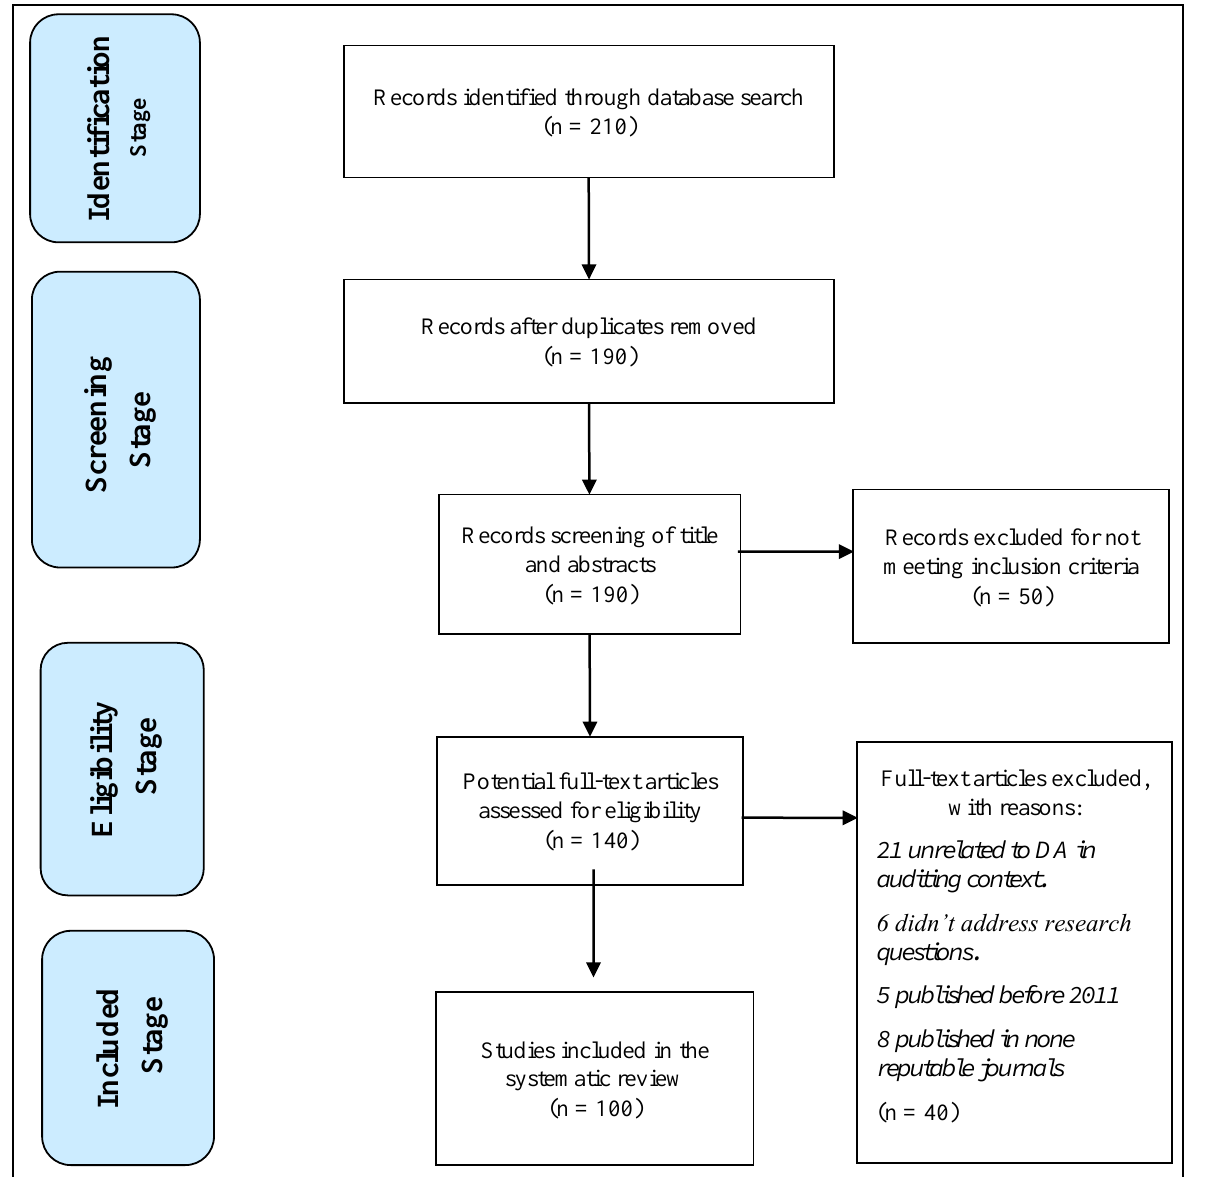
Figure 2. Flow diagram of papers included in review based on